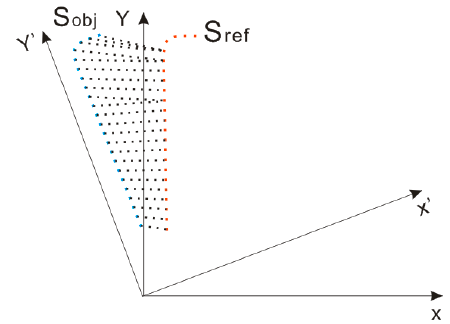
Figure 2. Two scans that were captured at the beginning and end of robot motion. The blue scan is the object scan ( S obj ) and the red scan is the reference scan ( S ref ). The dotted lines are the correspondence based on the criterion of the closest